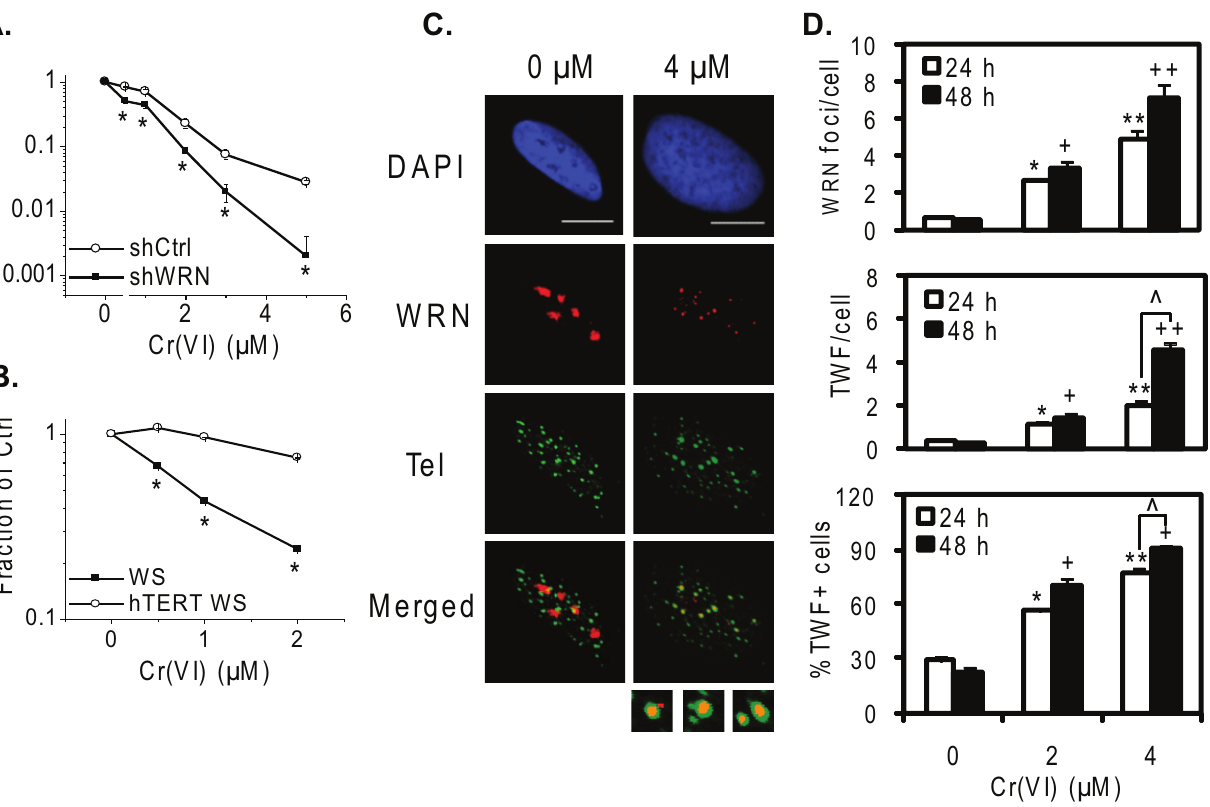
Figure 4. WRN protects against Cr(VI) cytotoxicity and localizes to Cr(VI) induced telomere damage. (A) Clonogenic assay of shCtrl and shWRN isogenic cells exposed to the indicated Cr(VI) concentrations for 24 h. (B) Cell viability assay. The cells were exposed to the indicated Cr(VI) concentrations for 48 h, and subpopulations of Cr(VI)-treated cells were subcultured in Cr(VI)-free medium for 8 days. In (A) and (B), the colony or cell number in the Cr(VI) treatments were expressed as a fraction of the untreated control. The data represent mean 6 SE from at least three independent experiments. Bars with a symbol are significantly different from the untreated (p , 0.05). (C) Confocal images of EYFP-WRN U2OS cells exposed to the indicated Cr(VI) concentrations for 48 h. Cells were subjected to IF-FISH for analysis of WRN (red) and telomere (green) colocalization (yellow). Bars, 10 m m. (D) Average WRN foci and telomere-colocalized WRN foci (TWF) per cell and the percent TWF positive cells. The data represent mean 6 SE from two independent experiments, based on at least 50 randomly chosen cells for each Cr(VI) treatment. Bars with a different number of symbols are significantly different from each other (p , 0.05).